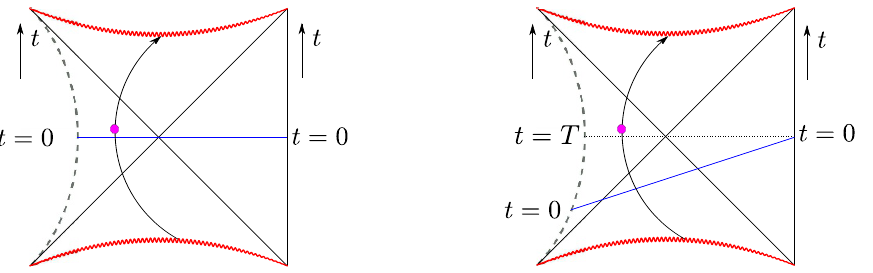
Figure 5 . Two di(cid:11)erent choices of localizing the mirror operators in physical time, corresponding to di(cid:11)erent identi(cid:12)cations of physical time t with the coordinate on the left region. The two diagrams correspond to di(cid:11)erent choices of T , the left diagram is for T = 0. Notice that the bulk geometry of the left region, if it is de(cid:12)ned relationally to the right boundary, is the same in both cases. However, the types of allowed active perturbations of the state are